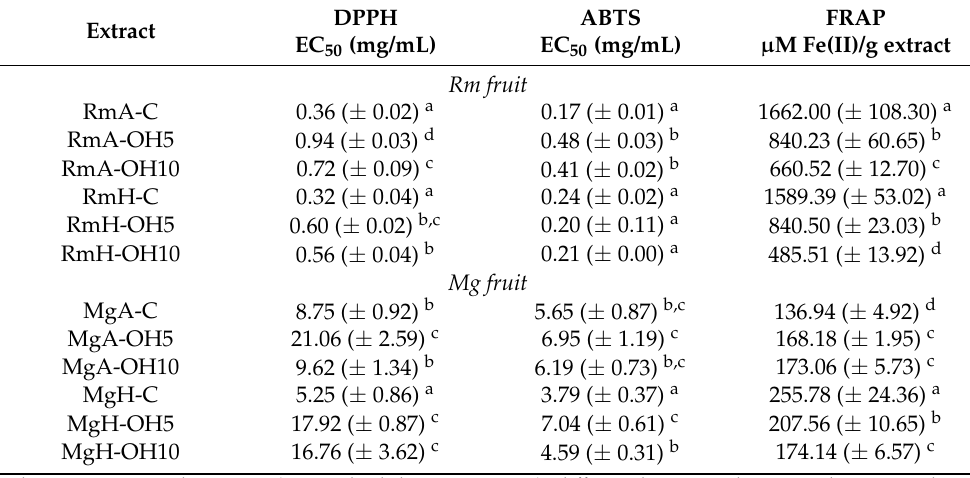
Table 5. Scavenging (DPPH, ABTS) and reducing (FRAP) properties of R. microphylla (Rm) and M. geometrizans (Mg) fruit extracts obtained by conventional agitation (C) and ohmic heating (OH). DPPH ABTS FRAP Extract µ M Fe(II)/g extract EC 50 (mg/mL) EC 50 (mg/mL) Rm